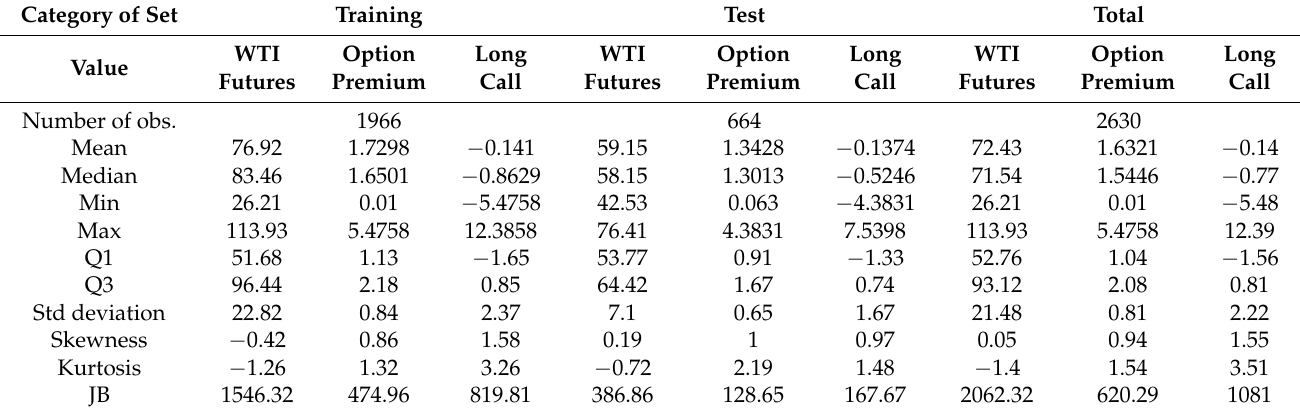
Figure 1. WTI crude oil futures prices (FP) and the long call option premium (OP) for front-month delivery (in USD per barrel). Table 1. Descriptive statistics of WTI futures prices, option premium and long call final results (in USD per barrel). Category of